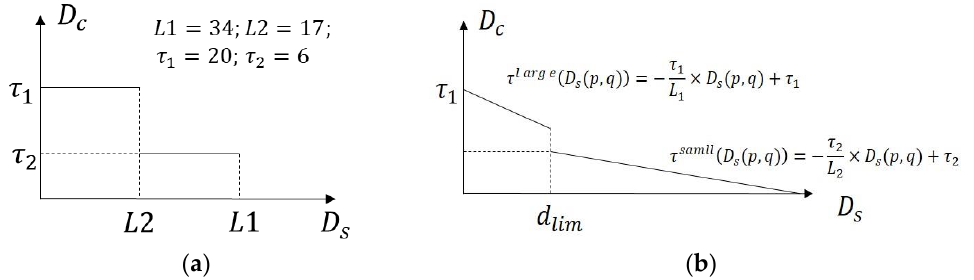
Figure 5. The spatial distance thresholds and color similarity thresholds proposed by Mei et al. [14] ( a ) and the adaptive color similarity threshold proposed by this paper ( b ).